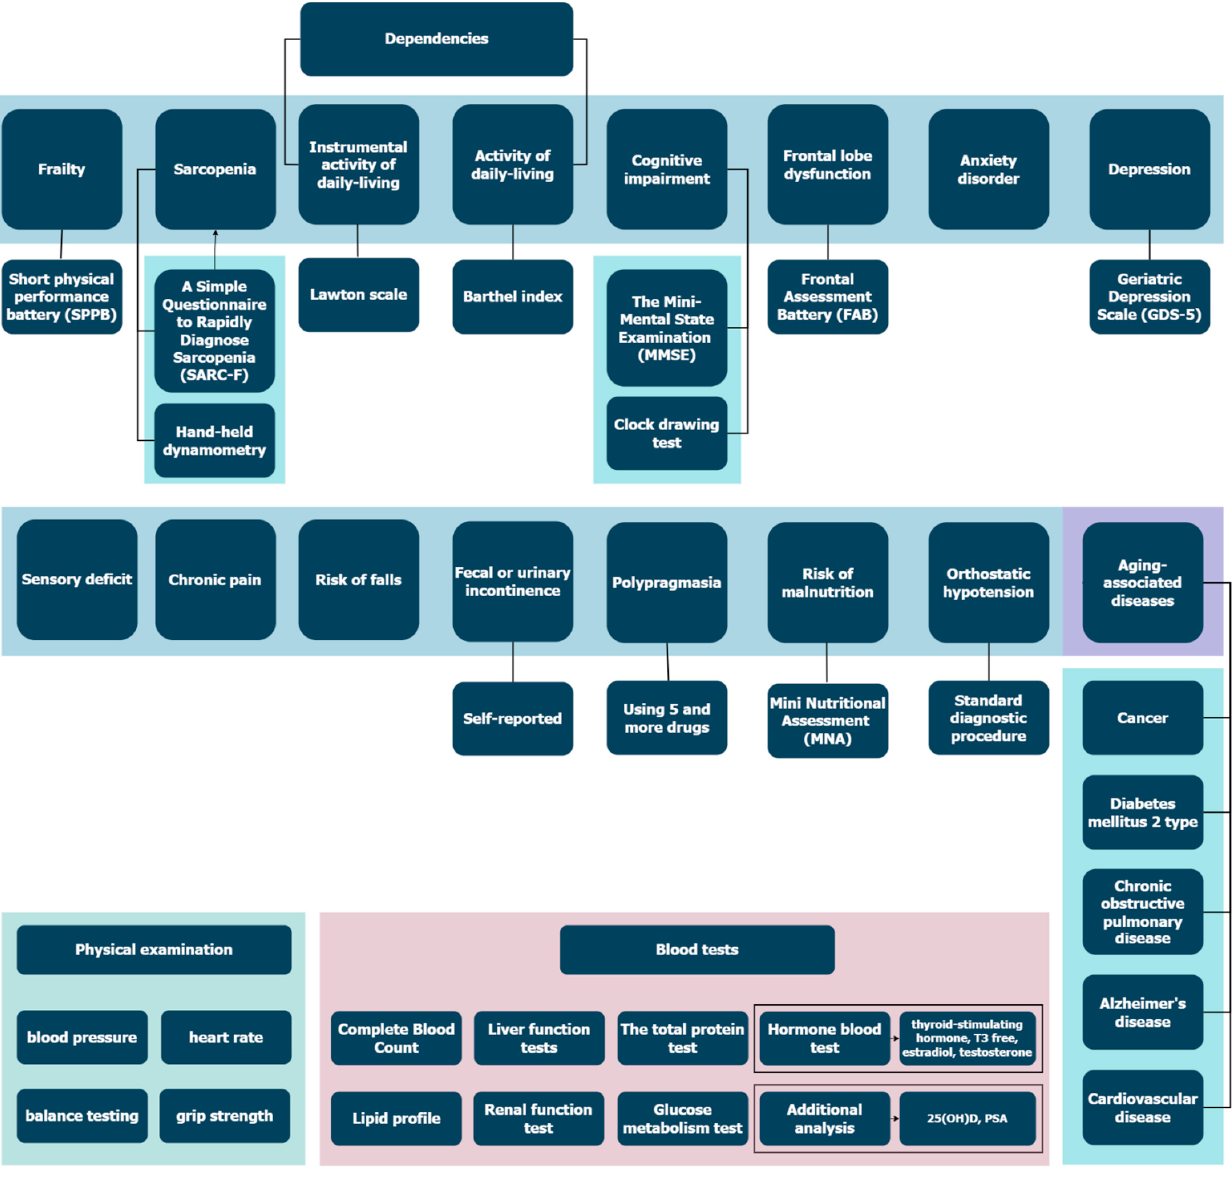
Figure 2. All procedures performed in the study. Please find questionnaires for Sensory deficit, chronic pain, risk of falls, anxiety disorder in Supplementary